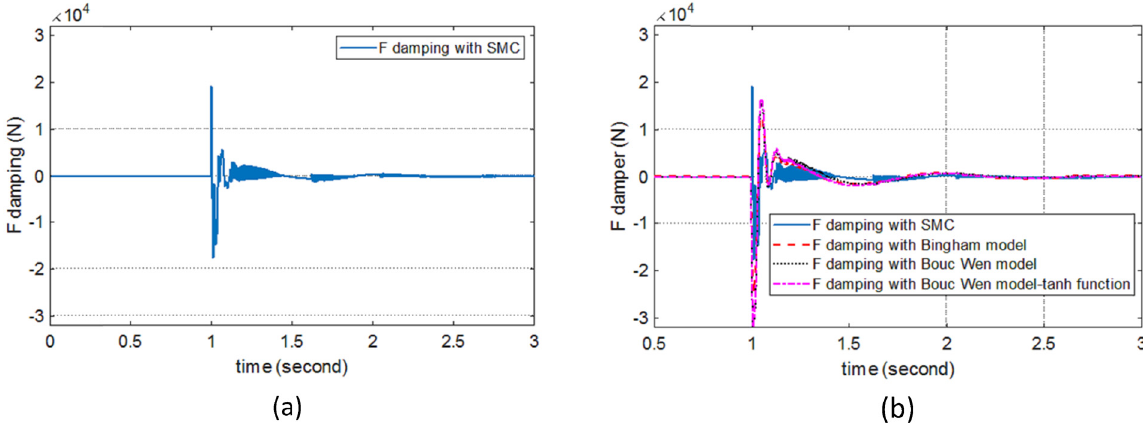
Figure 5: Damping force: ( a ) damping force: SMC and ( b ) damping force SMC and